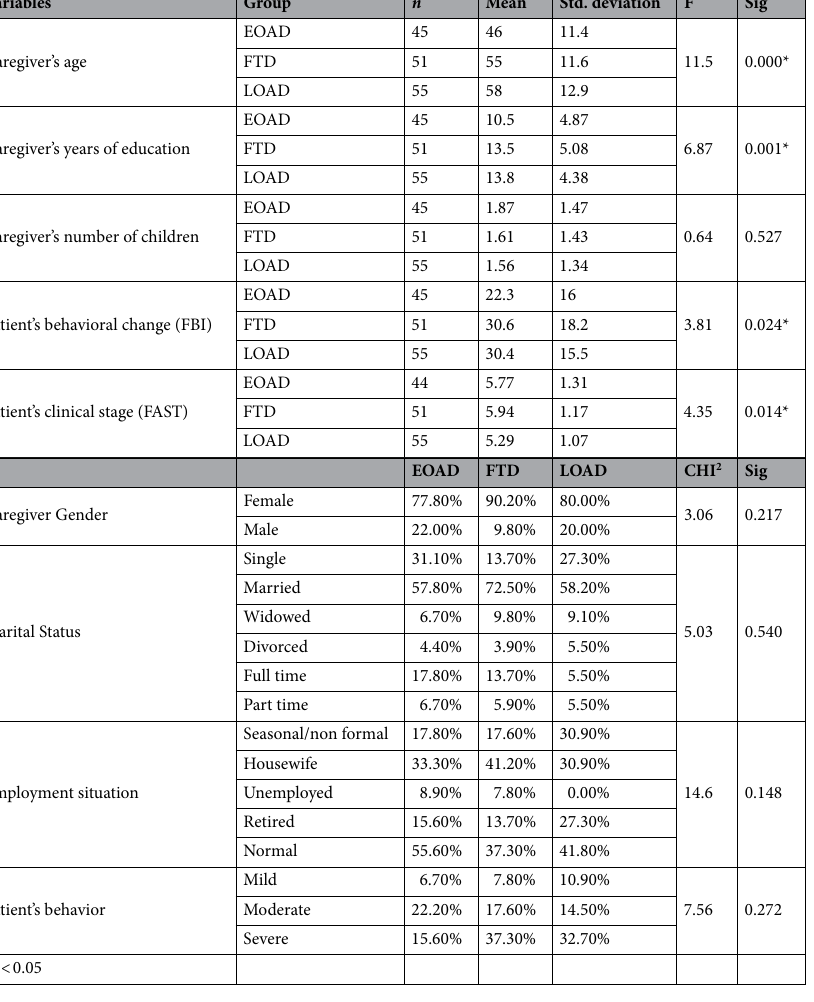
Table 1. Clinical and sociodemographic